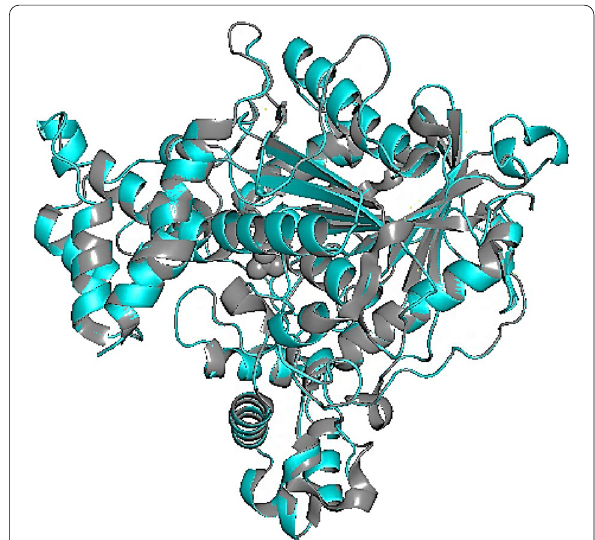
Fig. 1 The superimposed structure of A. pisum AChE enzyme (cyan) and its best homologous template-chain A of 1D